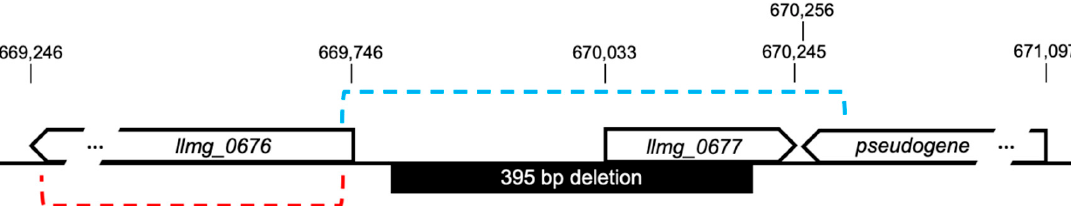
Figure 4. Genomic region encompassing the deletion found in BIM p2 ∆ 47 . The dashed blue line indicates the region cloned into pNZ123 for complementation. The dashed red line indicates the region deleted for gene inactivation.